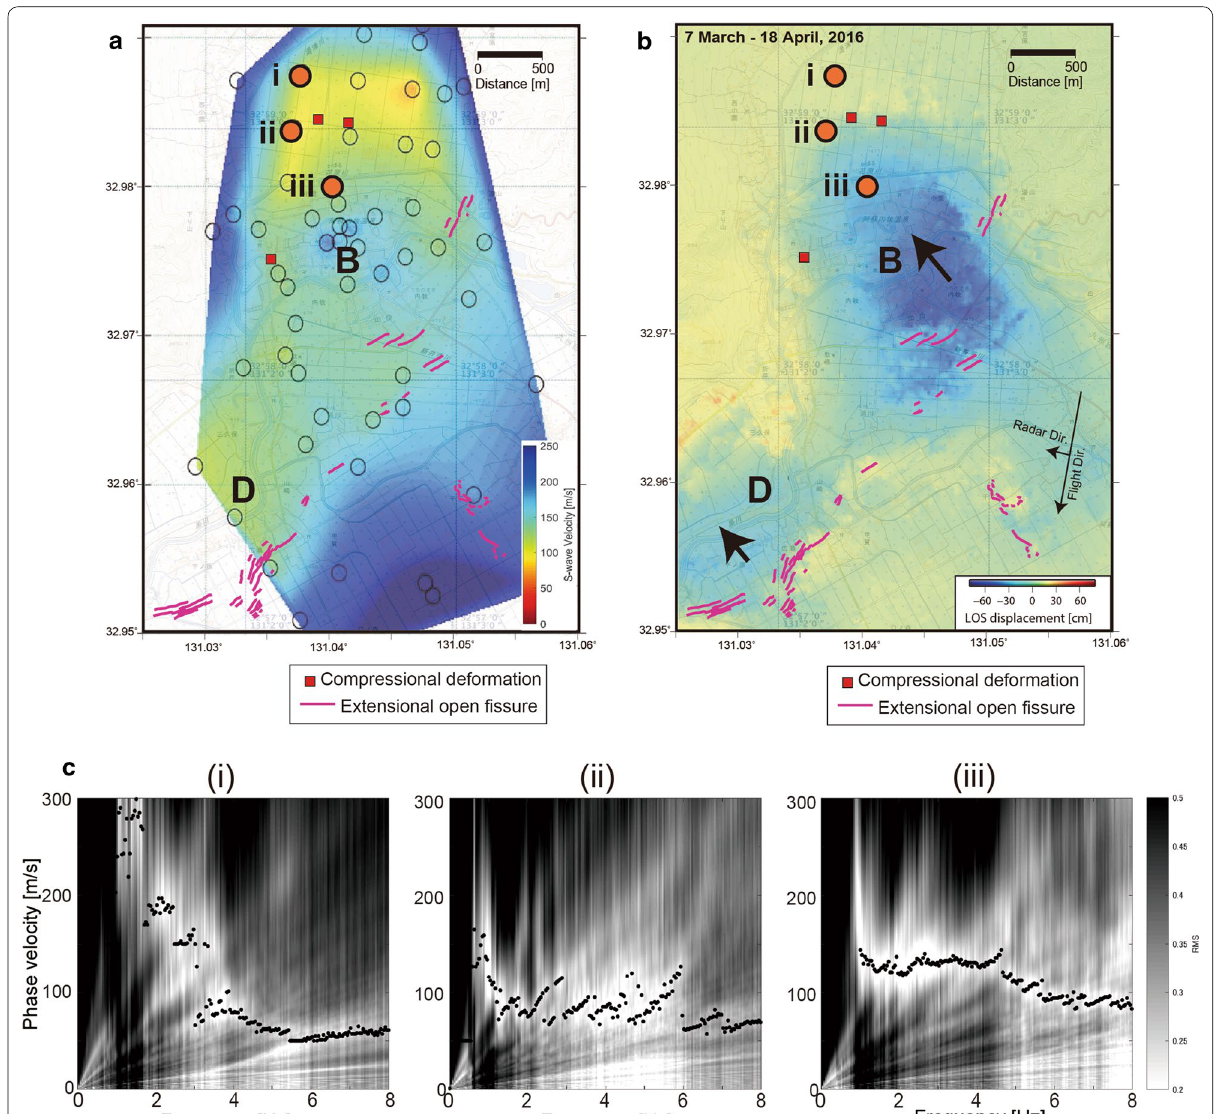
Fig. 4 Comparison of a S-wave velocity at 20 m depth and b surface deformation derived from DInSAR data (right-looking during descending orbits) from 7 March to 18 April 2016 (Tsuji et al. 2017). Purple lines represent open fissures interpreted from field observations and satellite data (Tsuji et al. 2017) and correspond to the northwestern boundary of the southern high-velocity region ( a ). The area of greatest displacement in b is in the area of the plume-shaped high-velocity anomaly near the center of the hot springs. c Comparison of dispersion curve at (i) northern paddy fields, (ii) compressional deformation area (fracture zone), and (iii) center of the hot spring (higher velocity). The locations of these survey positions are shown in a ,